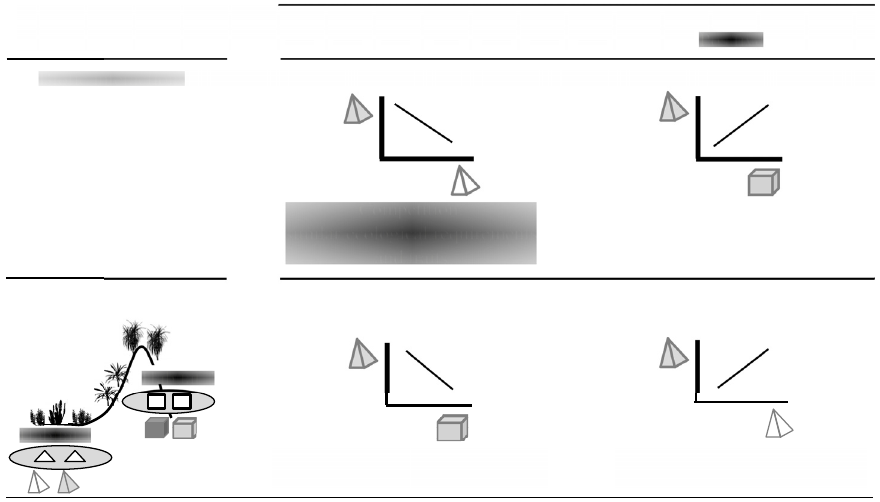
Fig 4. Expected covariance between species involved in biotic interactions and environmental filtering. The combination of 3-d shapes and colors represent four different species. Species with similar requirements (syndromes) are represented by the same shape (pyramids: Tertiary (T), cubes: Quaternary(Q)), but distinct colors. Environmental filters are represented as grey ellipses in which only species with certain traits can survive (e.g. moist and shaded environments on north facing slopes where species with a tertiary syndrome can survive, or sunny environments on south facing slopes where quaternary species can survive: the 3-d shapes must match the shape of the ellipse). In the case of negative abundance covariance, competition is expected to be more intense between species with similar traits and ecological requirements resulting in spatial segregation between species with similar requirements and traits, while environmental filtering will result in spatial segregation between species with dissimilar requirements and traits. In the case of positive abundance covariance, facilitation promotes the co-occurrence between species with dissimilar requirements and traits, while habitat filtering results in the co-occurrence of species with similar requirements and